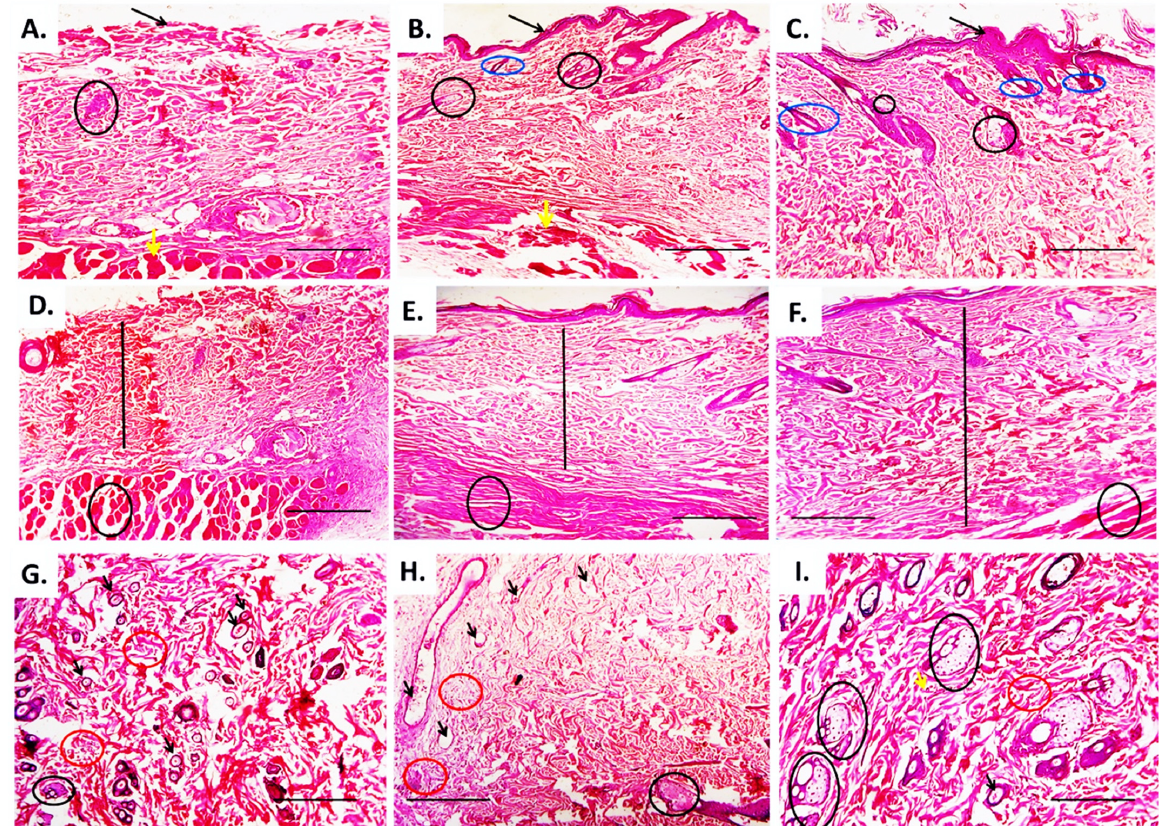
Figure 9. Effect of the hydrogel topical application of cefepime and CFE for successful 14 days on the histopathological changes of the clinical isolates of P. mirabilis -infected diabetic wound in rats ( A – I ). ( A ) a photomicrograph of the diabetic infected untreated wound showing sloughed epidermal layer (black arrow), degenerated sebaceous gland (black circle), and smooth muscle (yellow arrow) H&E × 100, ( B ) a photomicrograph of cefepime-treated diabetic infected wound showing indefinite thin epidermal layer (black arrow), few degenerated sebaceous glands (black circle) and hair follicles (blue circle), and smooth muscle (yellow arrow) H&E, × 100, ( C ) a photomicrograph of clove ethanolic-extract treated diabetic infected wound showing thick well defined multicellular epidermal layer (black arrow), numerous regenerated hair follicles (blue arrow) and sebaceous glands (black circle), and well defined smooth muscle fiber (yellow arrow), H&E, × 100, ( D ) a photomicrograph of diabetic infected untreated wound showing narrow dermal layer with few depositions of collagen and granulation tissue (black line) and a severely degenerated muscular layer (black circle), H&E, × 100, ( E ) a photomicrograph of diabetic cefepime-treated diabetic infected wound showing moderate; dermal thickness (black line) and muscular degeneration (black circle), H&E, × 100, ( F ) a photomicrograph of clove ethanolic extract-treated diabetic wound showing heavy deposition of both collagen and granulation tissue with increasing dermal thickness (black line) and unaffected muscular tissue (black circle), H&E, × 100, ( G ) a photomicrograph of untreated diabetic infected wound showing severely congested blood vessels (black arrow), degenerated sebaceous glands (black circle), and abundant leukocytic infiltration with few fibroblastic ones (red circle), H&E, × 100, ( H ) a photomicrograph of cefepime-treated diabetic wound showing moderate blood vessel congestion (black arrow), leukocytic infiltration (red circle), and few sebaceous glands, H&E, × 100, ( I ) a photomicrograph of clove ethanolic extract-treated diabetic infected wound showing mild leukocytic infiltration (red circle), blood vessel congestion (black arrow), and numerous sebaceous glands with obvious filtration of fibroblast cells (yellow arrow), H&E, ×